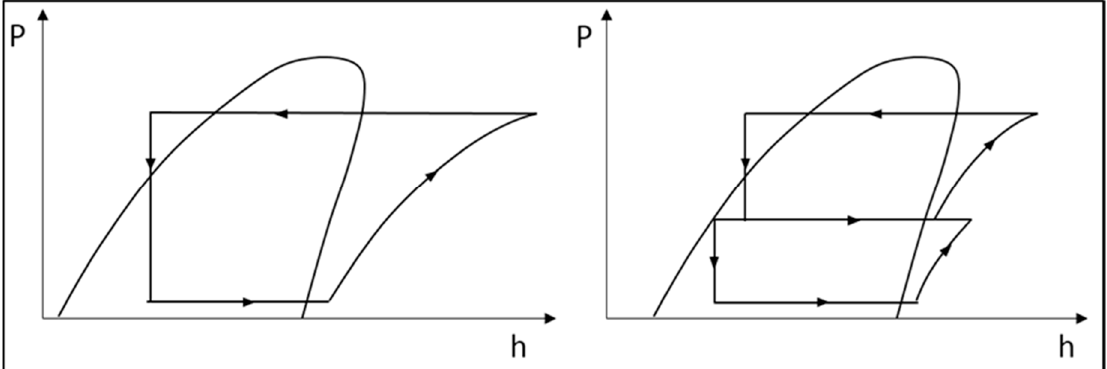
Figure 1. P-h thermodynamic cycle diagrams of single-stage ( left ) and two-stage ( right ) centrifugal compressors .